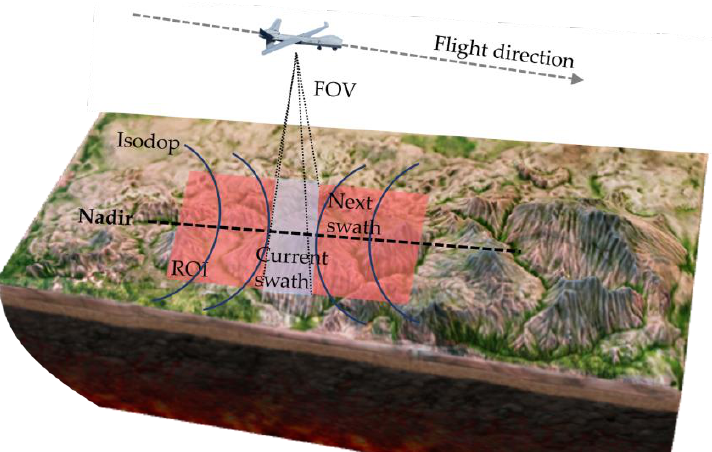
Figure 3. Simplified IRA measurement procedure.